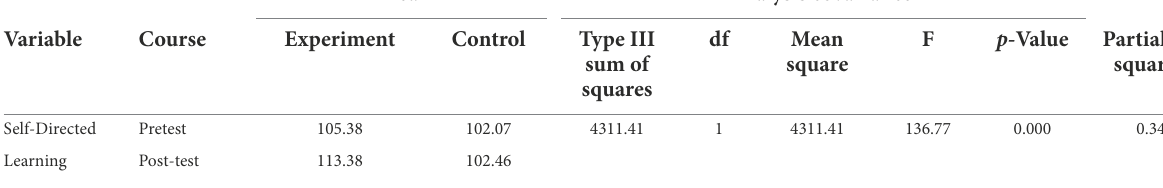
TABLE 5 Results of analysis of covariance for self-directed learning.